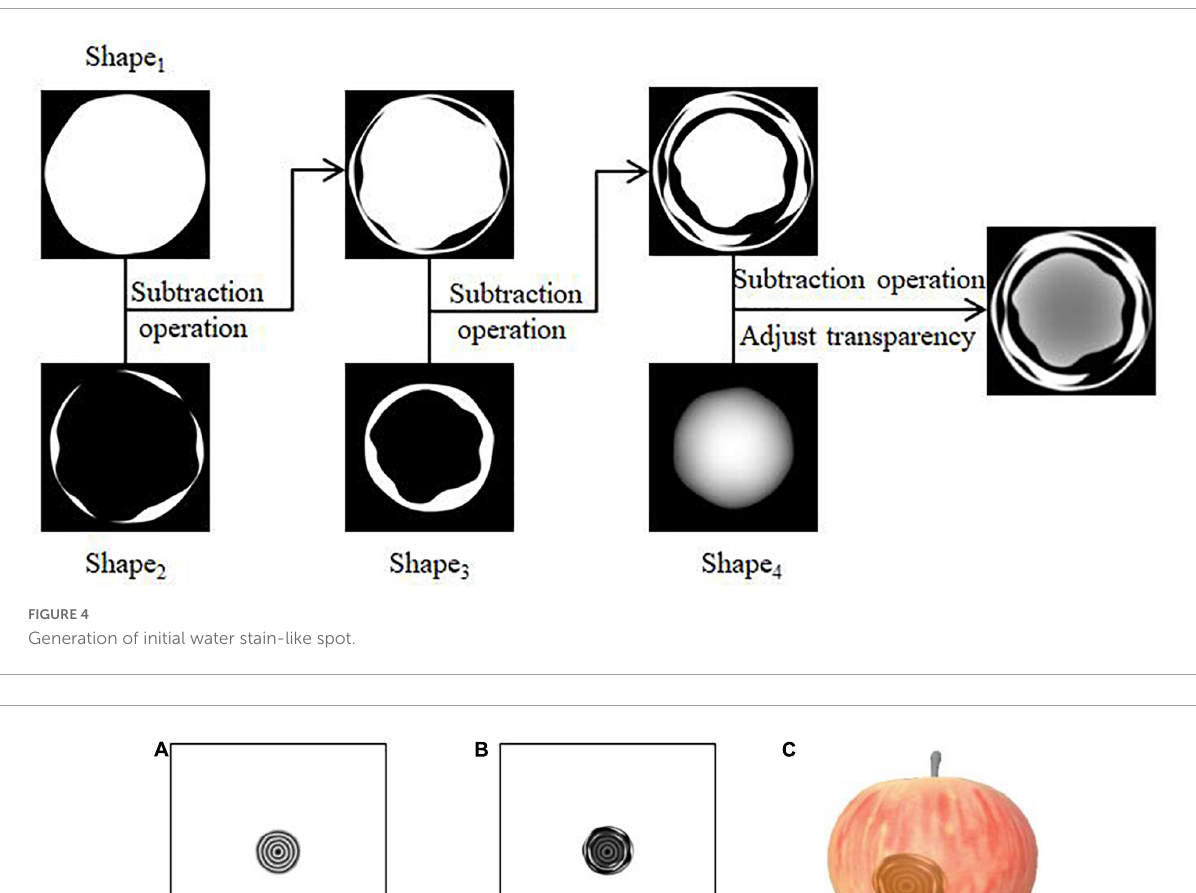
FIGURE5 Schematic diagram of cucumber powdery mildew simulation. (A) Concentric circle map after random disturbance, (B) map after superposition of initial lesion, (C) rendering